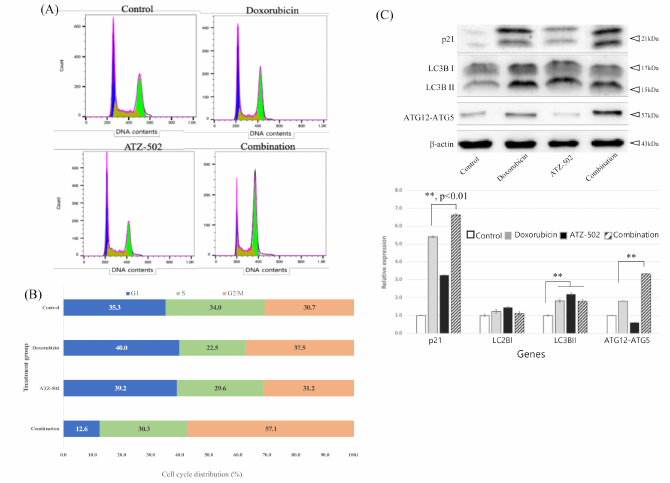
Figure 4. Cell cycle analysis of MDA-MB 231 cells. ( A ) Cell cycle analysis of MDA-MB 231 cells by FACS after treatment with doxorubicin only (1 µ M), ATZ-501 (1 µ M) only, and the combination treatment of both doxorubicin (1 µ M) and ATZ-502 (1 µ M). ( B ) Representative histogram graph of the cell cycle analysis of MDA-MB 231 cells. After combination treatment, MDA-MB 231 cells were inhibited in the G2/M phase (in comparison to the single treatments). ( C ) Change in autophagy- related proteins (ATG12-ATG5, LC3B1, and LC3BII) after combination treatment with doxorubicin and ATZ-502. **, p < 0.01; bars,